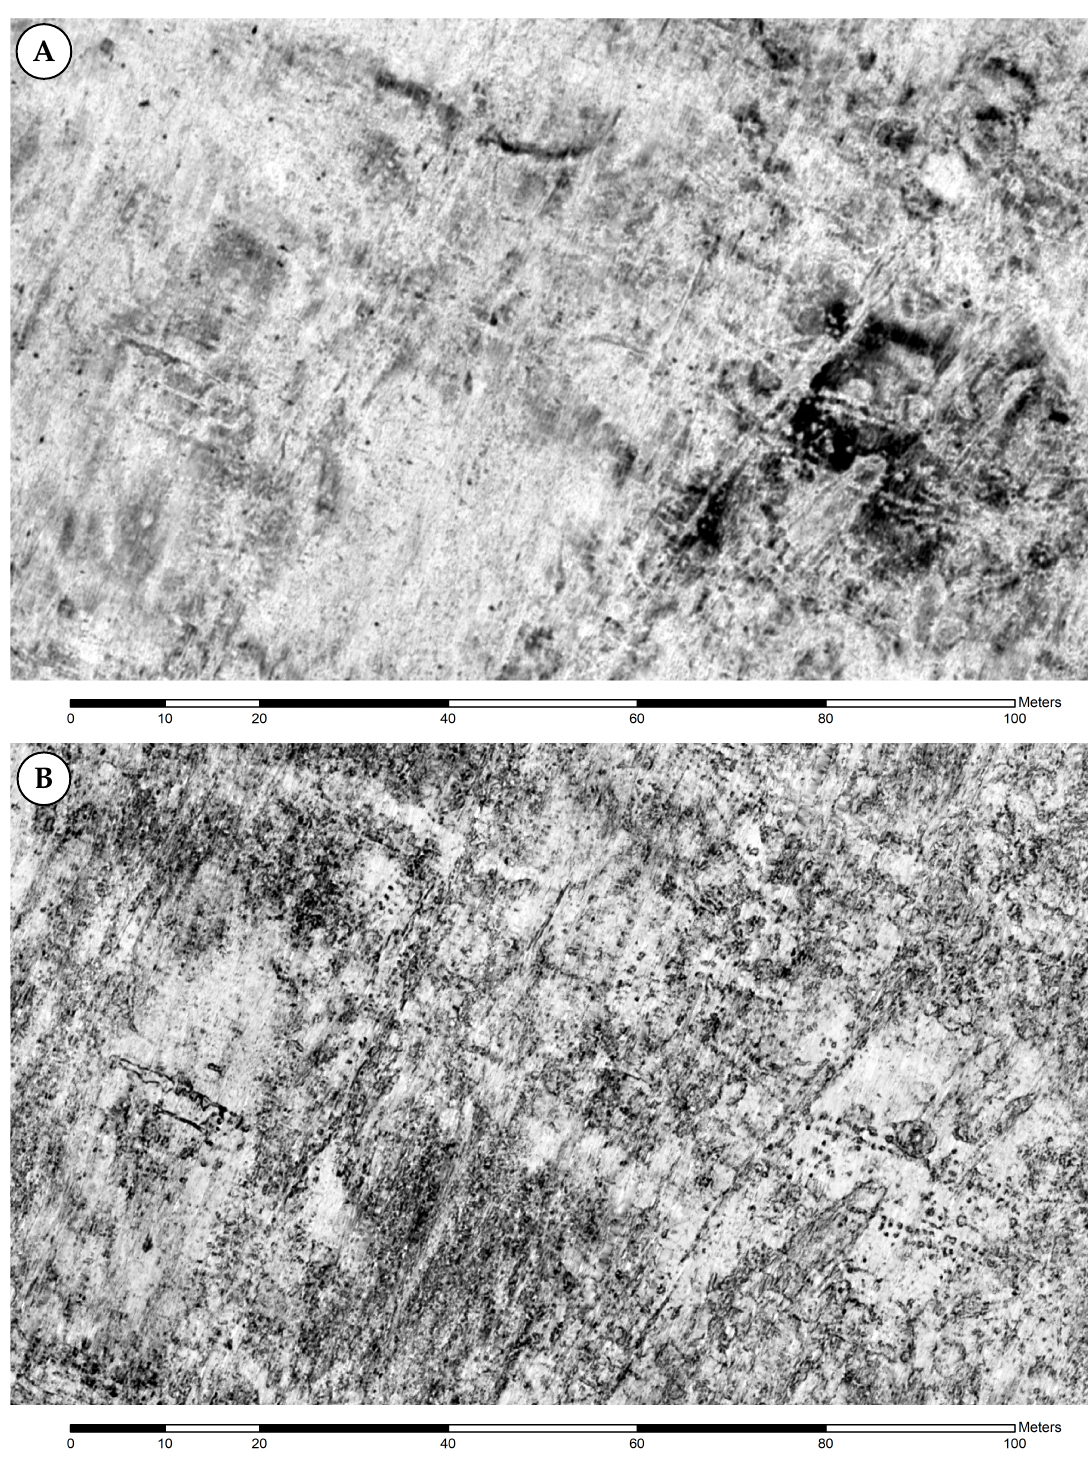
Figure 5. Stadil Mølleby: Migrated GPR depth-slices from 55–85 cm depth showing the same area. ( A ) Conventional reflection amplitude map. ( B ) Inline coherence image. Note the numerous rows of pits indicating building remains clearly visible in the coherence